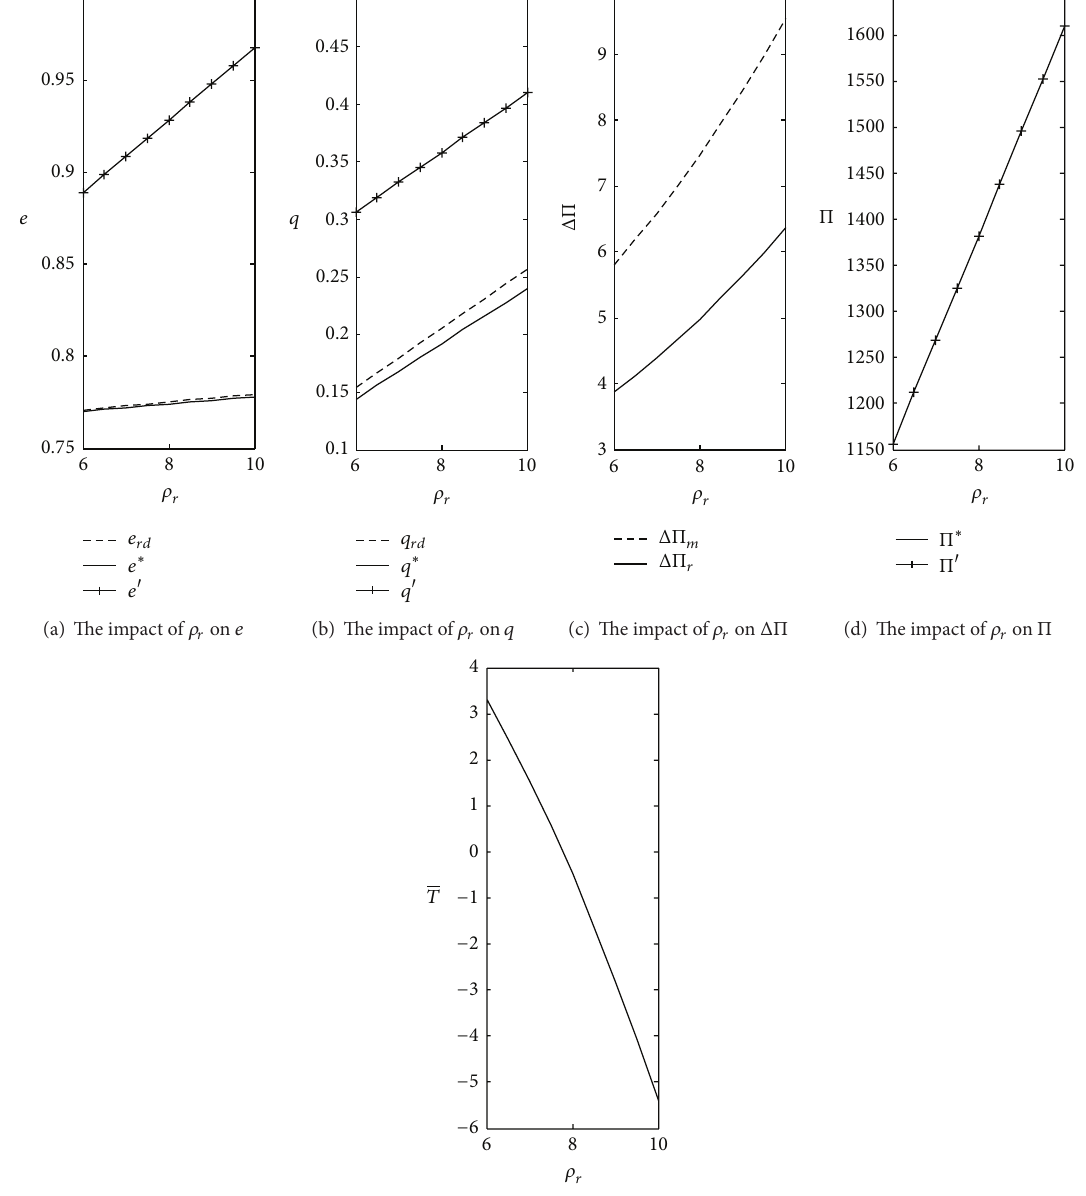
Figure 2: The impact of 𝜌 𝑟 on decision variables and